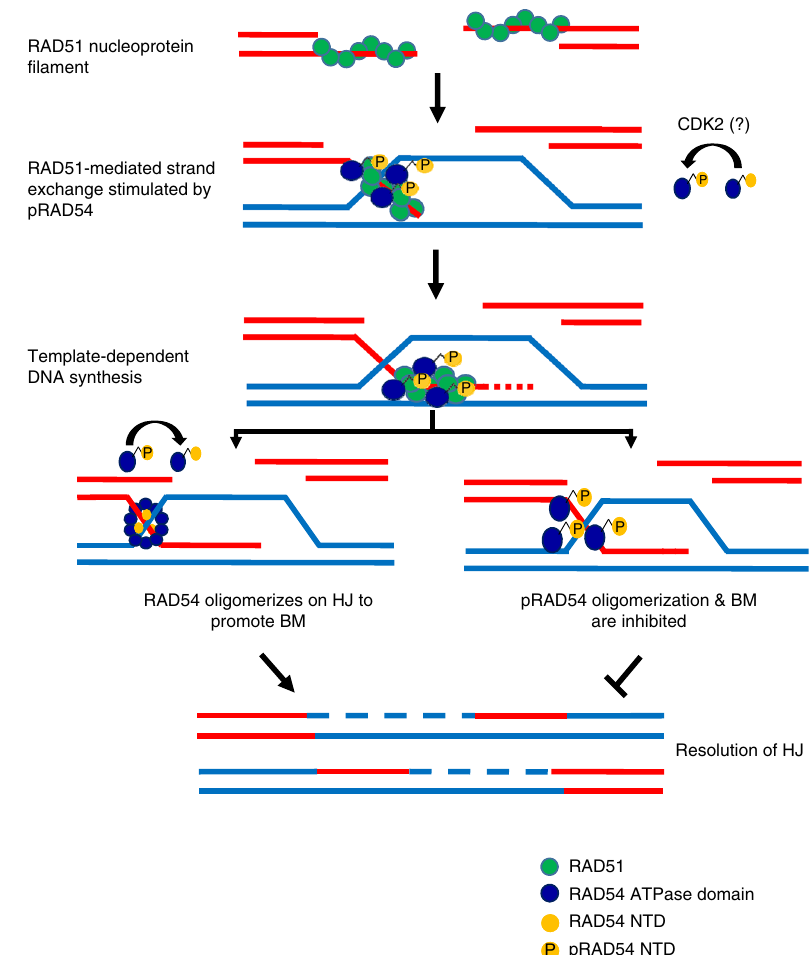
Fig. 7 Proposed mechanism of regulation of the RAD54 activities. The initial steps of HR involve exonucleolytic processing of DSB ends producing 3 ′ ‐ ssDNA overhangs, the formation of RAD51 ‐ ssDNA nucleoprotein fi laments, search for homology, and strand invasion into the homologous duplex DNA ‐ template leading to the formation of joint molecules (D ‐ loops). In its phosphorylated form, RAD54 can stimulate the strand exchange activity of RAD51. However, pRAD54 is unable to form an oligomer that is required for D-loop dissociation through BM; thus inhibiting RAD54 BM activity may provide suf fi cient time for the extension of the invading strand by a DNA polymerase. During later stages of HR, pRAD54 needs to be dephosphorylated so that BM could occur to complete the DSB repair process. Thus, phosphorylation modulates activities of RAD54 during